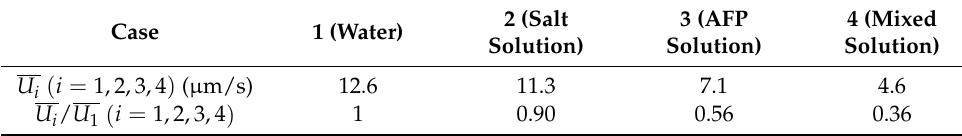
Table 3. Overall interface velocities and their